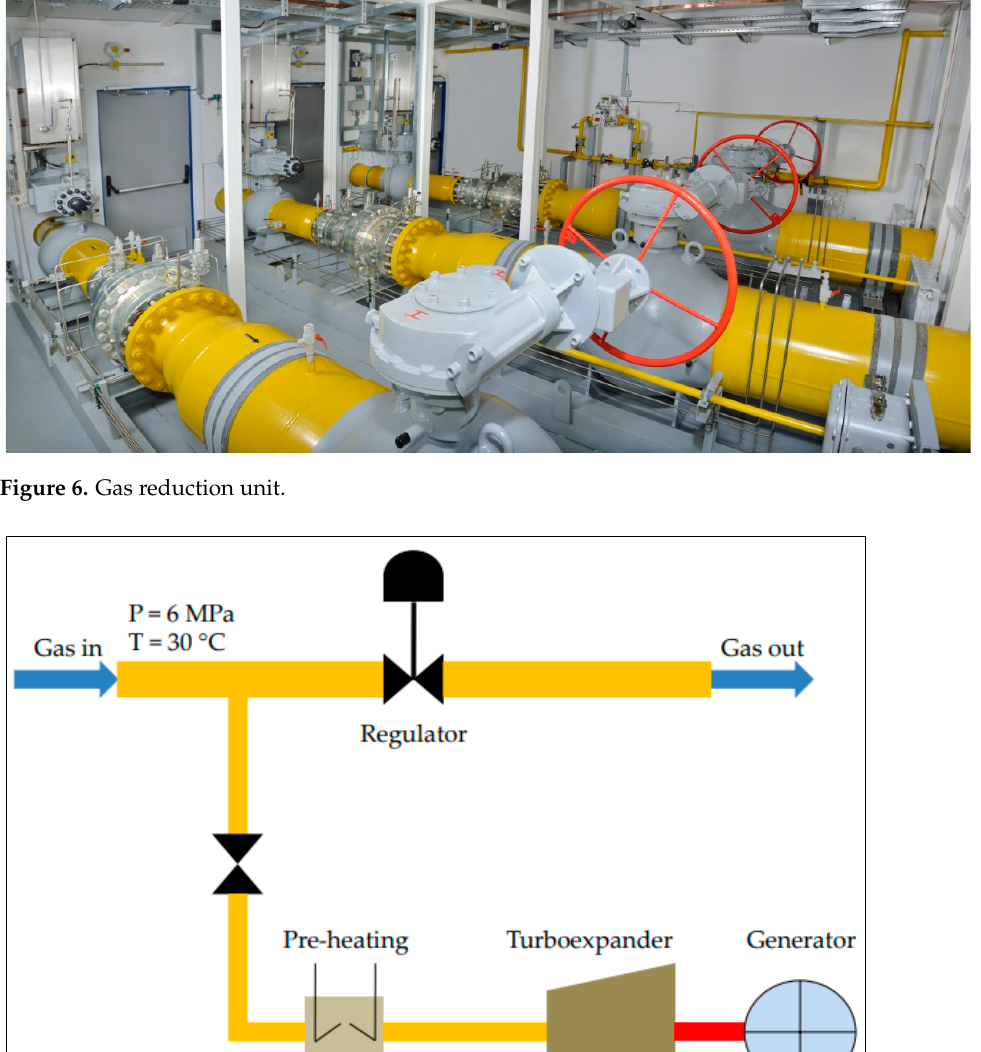
Table 7. Capacity of GDS. Month